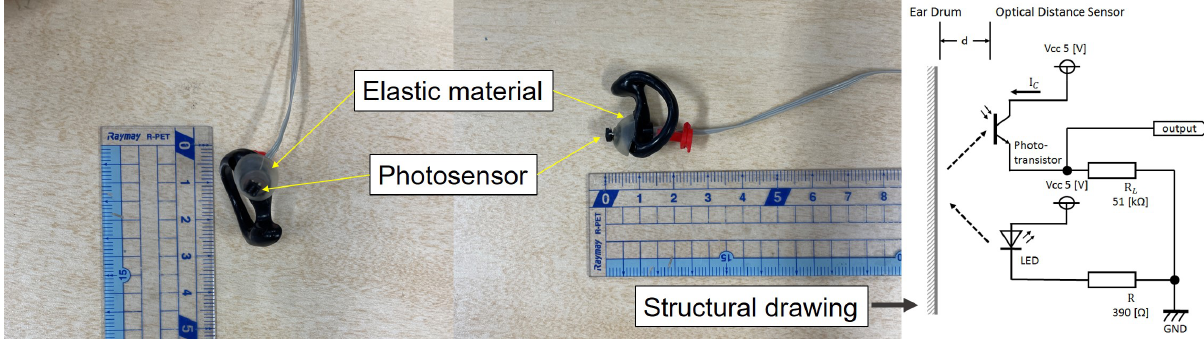
Figure 1. Earable Ω